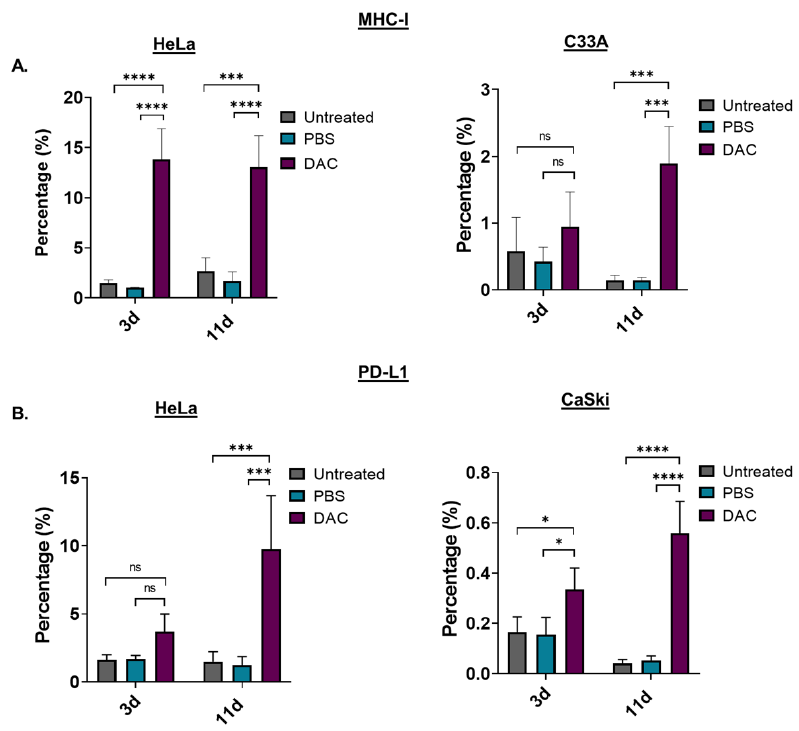
Figure 5. DAC treatment induces MHC-class I and PD-L1 expression on CC cells. ( A ) Percentage of the MHC-I positive cells in the untreated, PBS-treated and DAC-treated HeLa and C33A cells at 3d and 11d post-treatment. ( B ) Cell numbers of PD-L1 positive cells in untreated, PBS-treated and DAC-treated HeLa and CaSki cells at 3d and 11d post-treatment. The cell number was normalized to the counting beads for each condition. The data represent average values from three independent experiments (mean ± SD). Statistical analysis was performed using two-way ANOVA with Tukey’s multiple comparisons test (* p < 0.05, *** p < 0.001, **** p < 0.0001, ns = not statistically